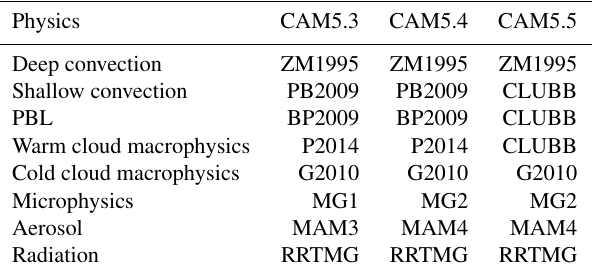
Table 1. Summary of physics used in each model version. Citation key: ZM1995 is Zhang and McFarlane (1995), PB2009 is Park and Bretherton (2009), BP2009 is Bretherton and Park (2009), P2014 is Park et al. (2014), MG1 is Morrison and Gettelman (2008), MG2 is Gettelman and Morrison (2014), G2010 is Gettelman et al. (2010), CLUBB is Golaz et al. (2002a), MAM3 is Liu et al. (2012), MAM4 is Liu et al. (2015), and RRTMG is Iacono et al. (2008). Physics CAM5.3 CAM5.4 CAM5.5 Deep convection ZM1995 ZM1995 ZM1995 Shallow convection PB2009 PB2009 CLUBB PBL BP2009 BP2009 CLUBB Warm cloud macrophysics P2014 P2014 CLUBB Cold cloud macrophysics G2010 G2010 G2010 Microphysics MG1 MG2 MG2 Aerosol MAM3 MAM4 MAM4 Radiation RRTMG RRTMG